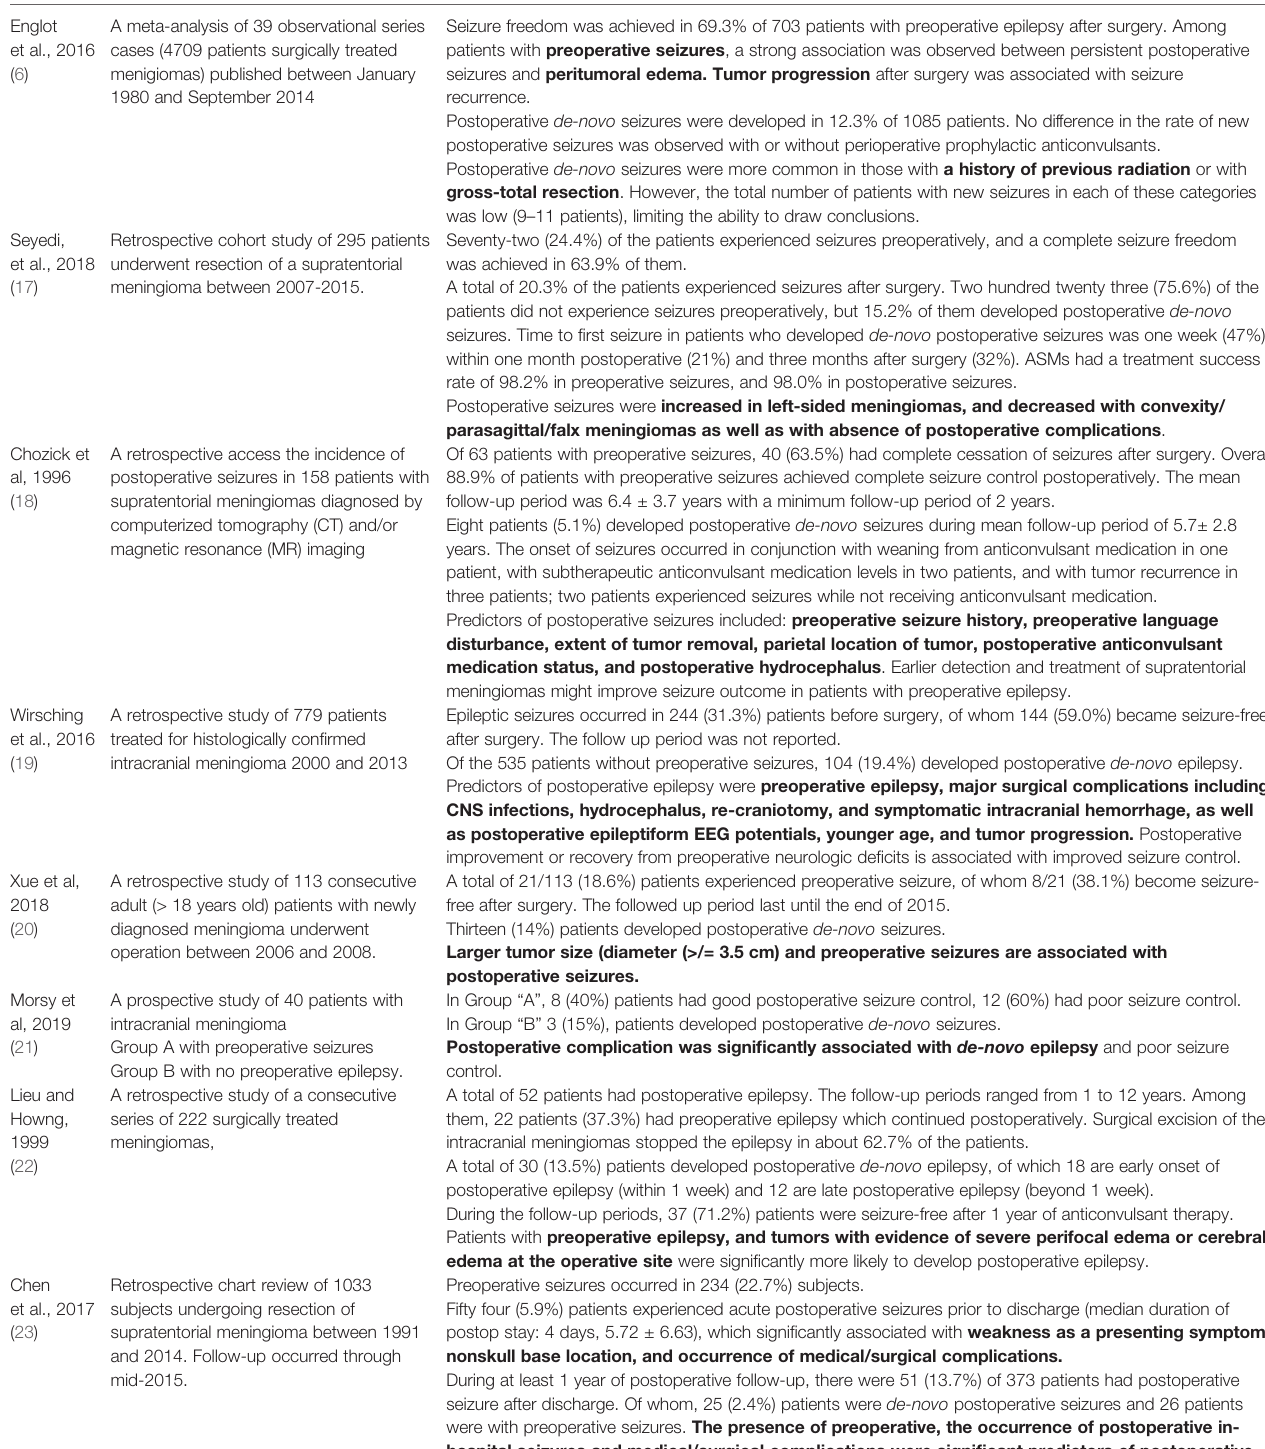
TABLE 2 | Predictors of postoperative epilepsy/seizures. Reference Study type Summary of fi ndings (bold texts indicating the proposed